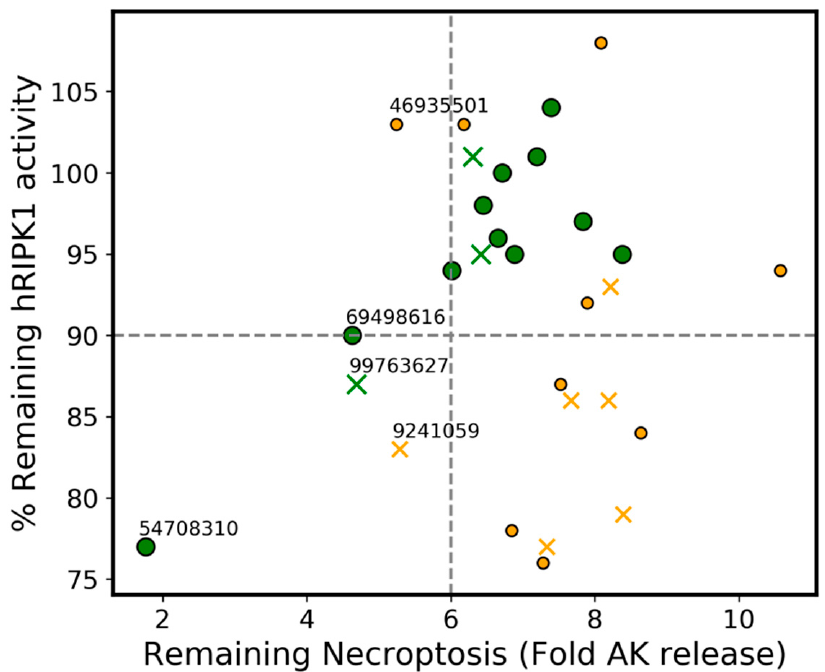
Figure 18. Qualitative correlation between phenotypic (X-axis) versus biochemical (Y-axis) readouts, with outliers detected by RANSAC identified in yellow. The “x” and “o” represent compounds tested at 5 µ M and 30 µ M, respectively, in the biochemical (hRIPK1 activity) assay. The labelled compounds are the top 5 candidates from the phenotypic assay. The grey dashed lines are a simple aid for qualitative analysis.